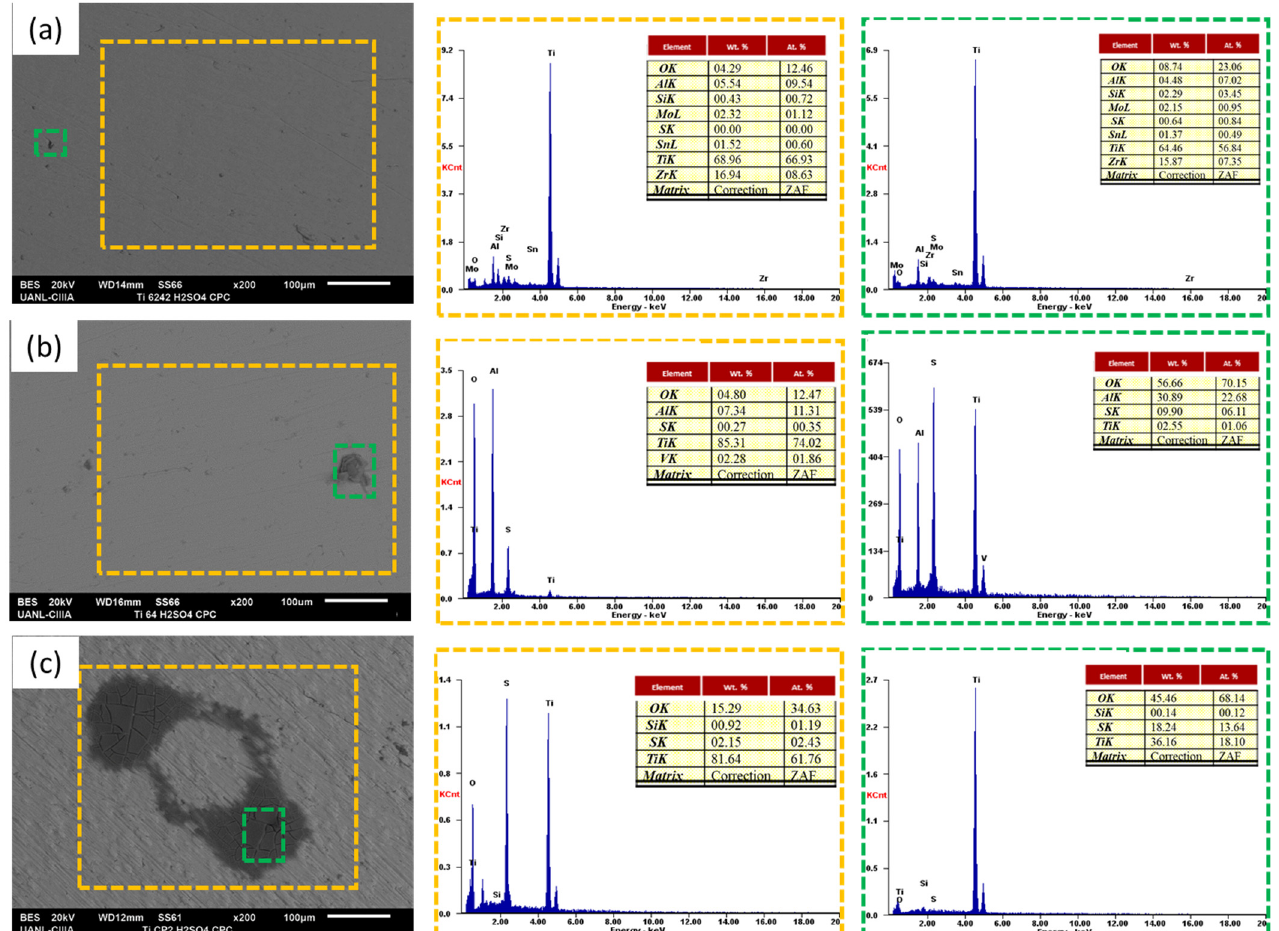
Figure 8. SEM-EDS surface morphology micrographs and EDS spectrum of titanium alloys exposed in a 3.5 wt % in H 2 SO 4 solution, ( a ) Ti-6Al-2Sn-4Zr-2Mo, ( b ) Ti-6Al-4V, and ( c ) Ti CP2.